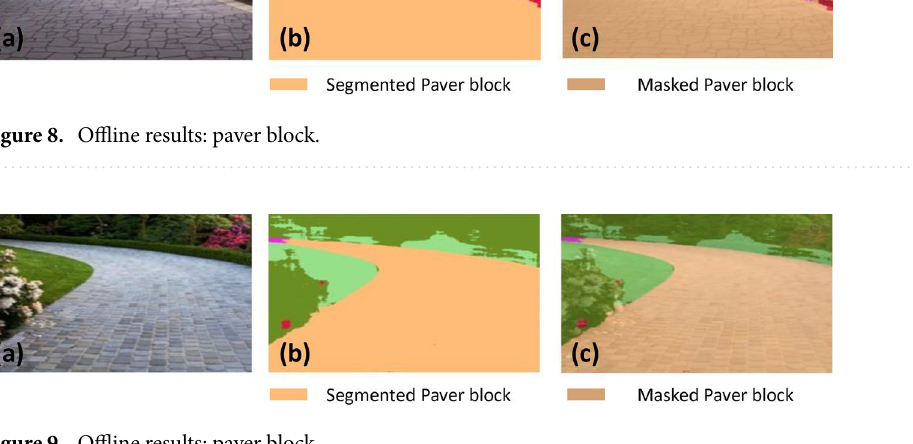
Figure 9. Offline results: paver